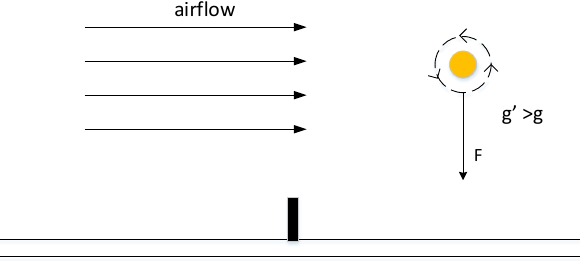
Figure 13. The pressure difference between the velocity of the ball up and down creates a downward force on the ball.